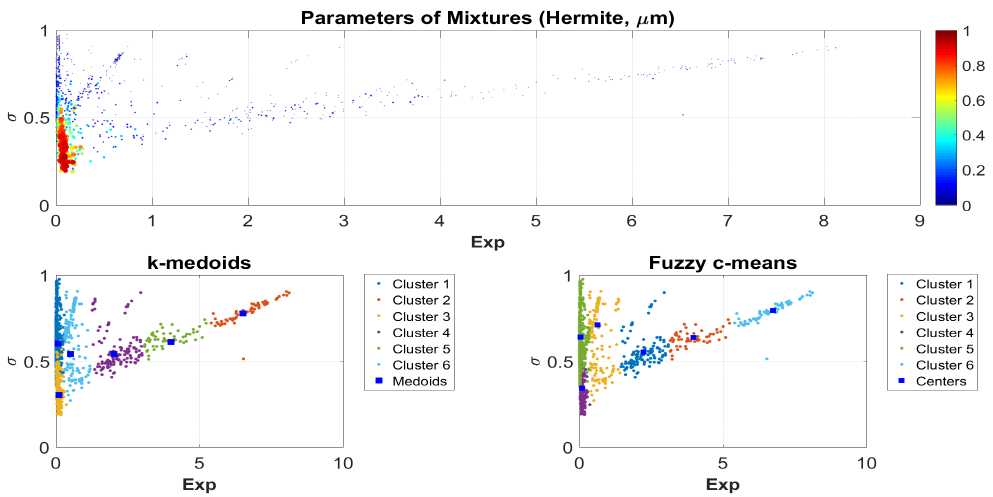
Figure A22. Clustering the mixture parameters (bootstrap, µ m).